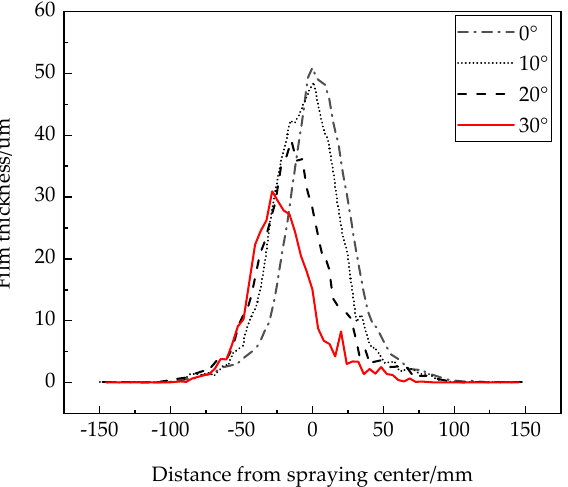
Figure 7. Cross-section curve of coating film thickness with different spraying inclination angles.